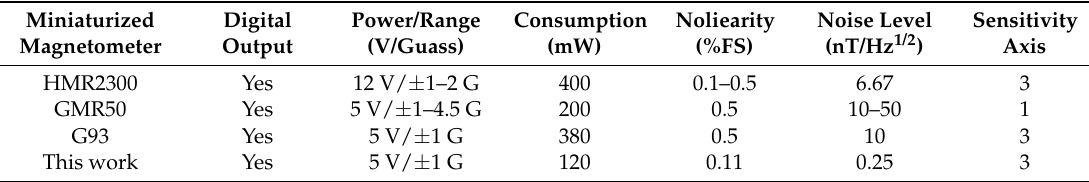
Table 1. Comparison of this work with other magneto-resistive